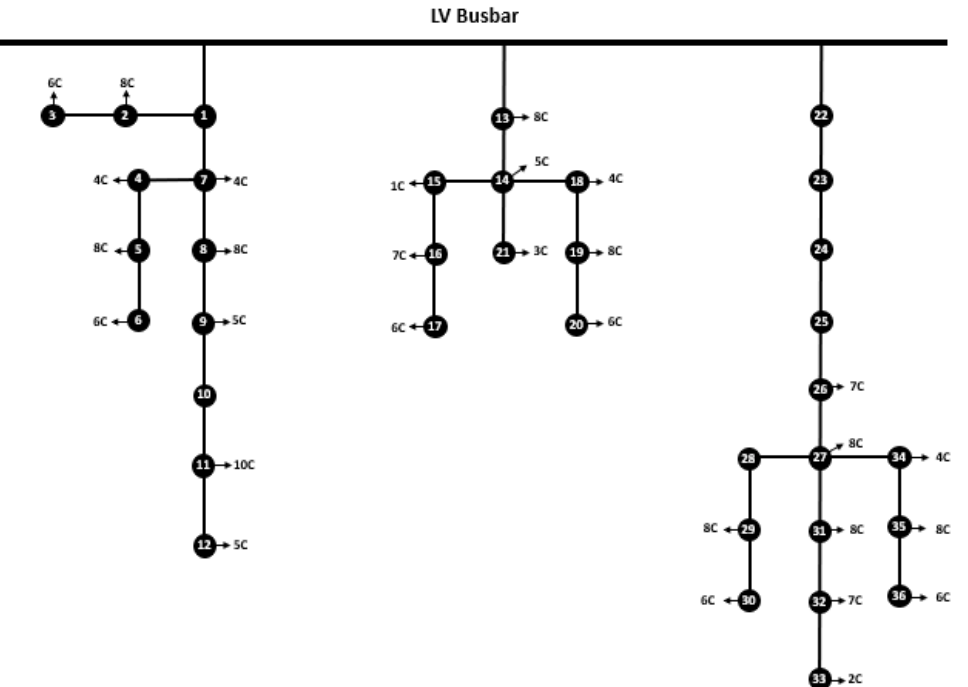
Figure 3. The low voltage (LV) network used in the case study.